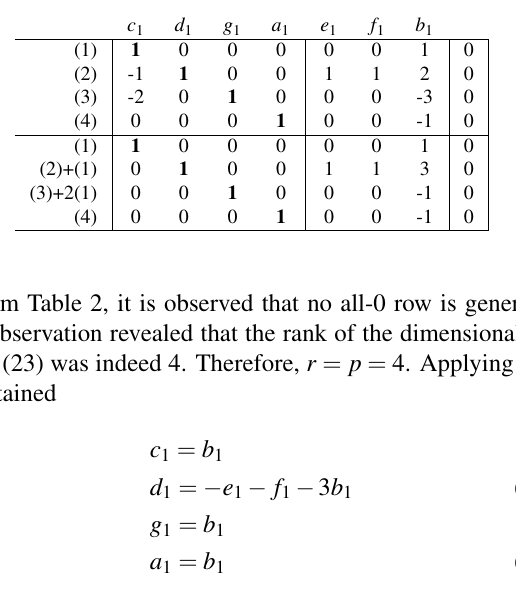
Table 2. Application of Gauss-Jordan elimination in the DA for the PD